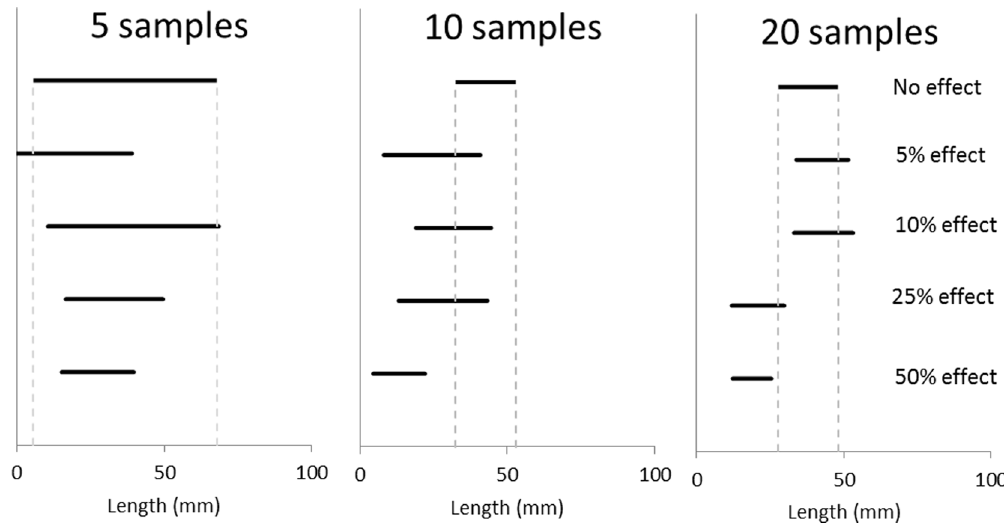
Figure 3. Example of how sample size and a stressor might influence estimates of mussel size in Lampsilissiliquoidea. Horizontal bars indicate the 95% credible interval of estimates of mean mussel size derived from either 5, 10 or 20 samples drawn from a normal distribution representing the samples collected in this study (no effect), or hypothetical samples collected from mussels where a stressor had reduced size by 5, 10, 25 or 50%. Vertical lines highlight the 95% credible interval for the ‘‘No effect’’ sample.